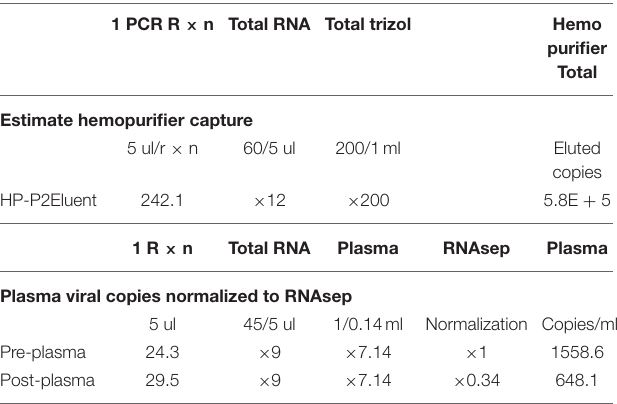
TABLE 2 | Hemopurifier viral capture and change in plasma viral load in case